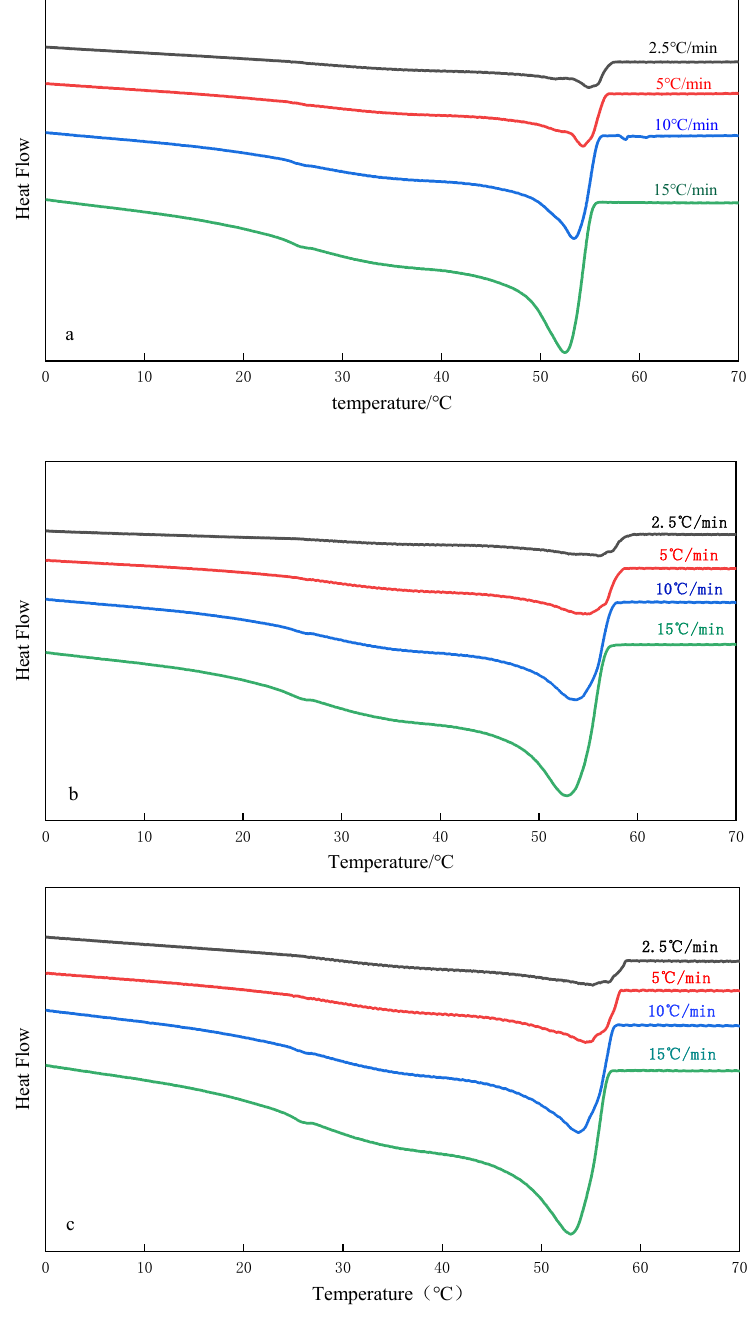
Figure 7. Non-isothermal crystallization DSC curves of different samples at various cooling rates: ( a ) VGO4, ( b ) VGO4 + 100 ppm AMAC, and ( c ) VGO4 + 100 ppm EMAC. Table 8. The non-isothermal crystallization parameters of